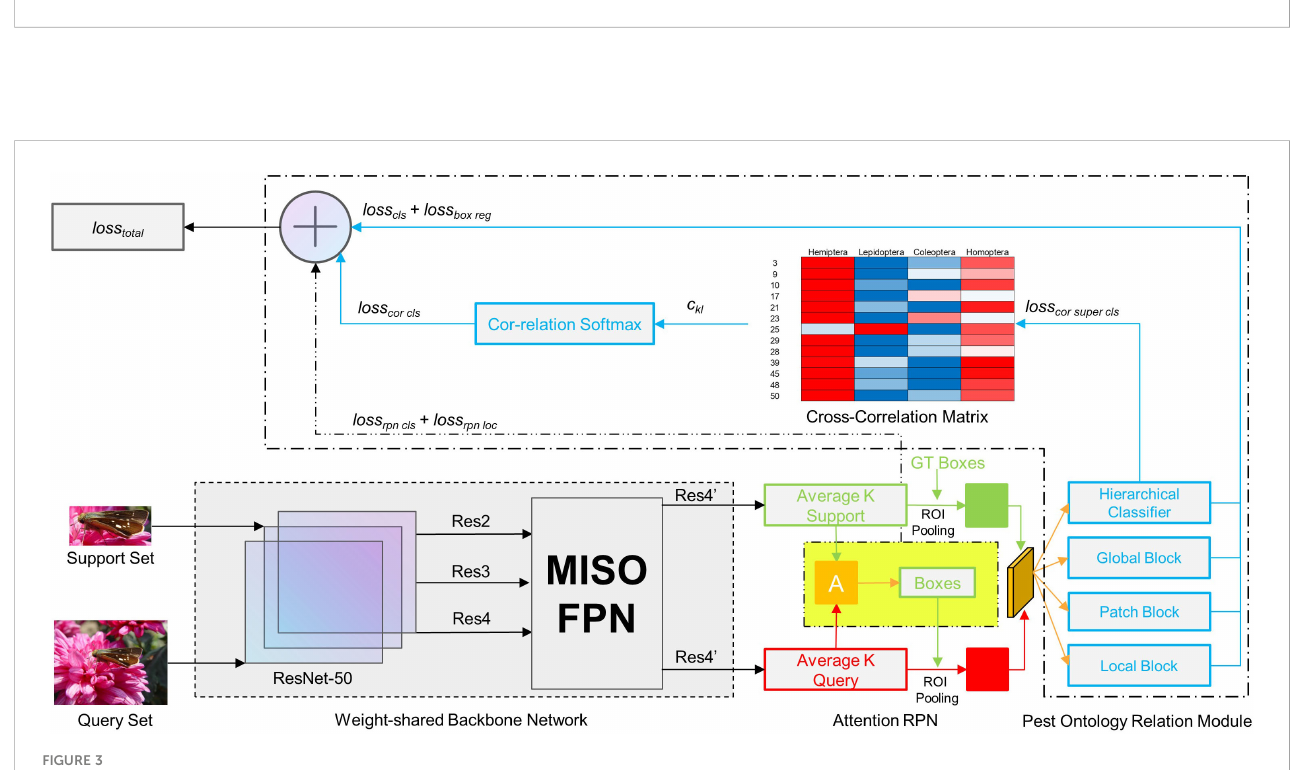
FIGURE 3 Framework of the proposed few-shot pest detection network.